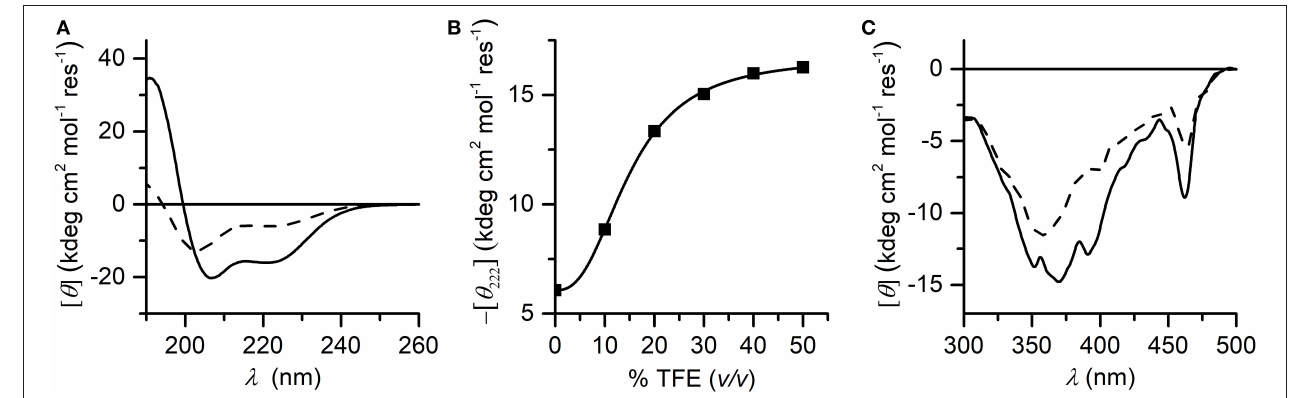
FIGURE 3 | (A) Far-UV CD spectra of Mn-MC6*a (2.0 · 10 − 5 M) acquired in 5mM phosphate buffered solution (pH 6.5) in absence (dashed line) and in presence (plain line) of 40% TFE ( v/v ); (B) titration curve showing –[ θ 222 ] as a function of TFE concentration (% v/v ). (C) CD spectra in the Soret-band region acquired in the same conditions of the panel (A) .